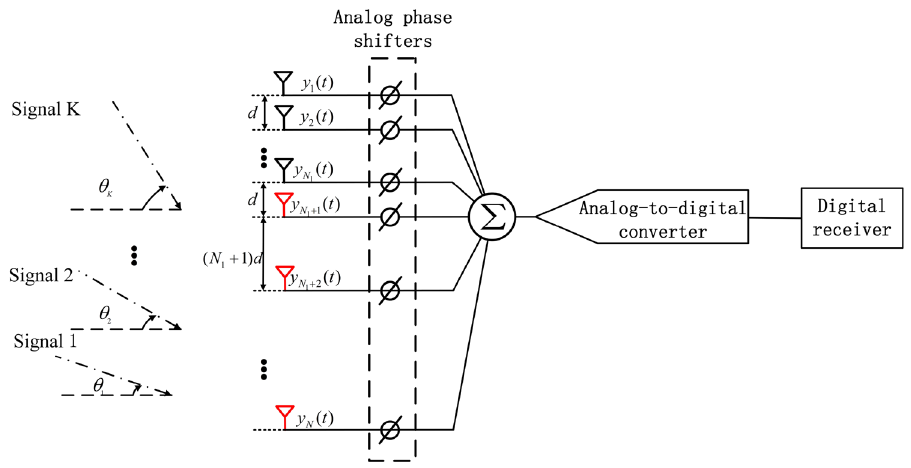
Figure 1. The hybrid analog-digital structure with nested